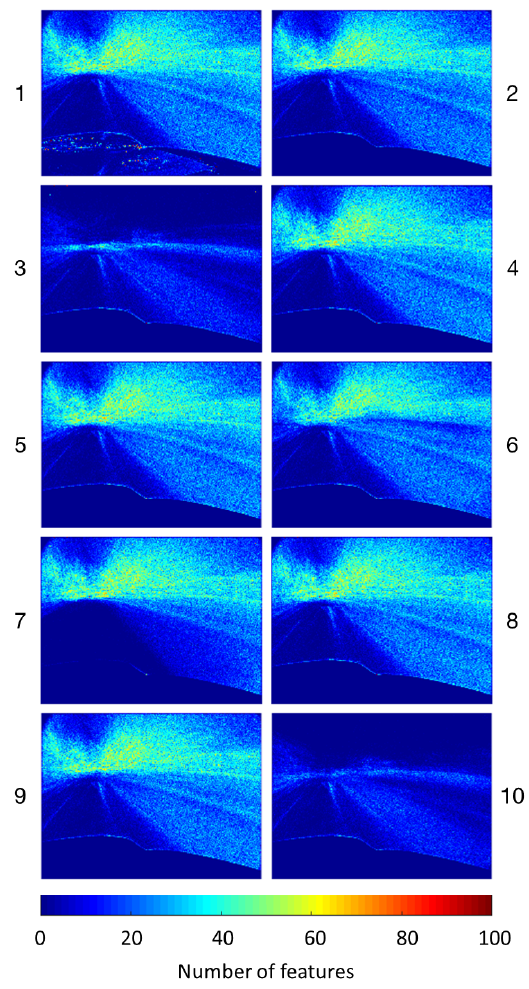
Figure 4. Deviations of interior orientation and distortion parameter values estimated by the proposed method from values Figure 3. Distribution of features across the complete image for estimated by reference calibration. Same scale for each left-right the different experiments. For only very few pixels, features pair. Experiment 3 is not shown as some of its deviation values occur more than 60 times. Values are referred to the complete are by magnitudes larger compared to the other sequence of 300 images.